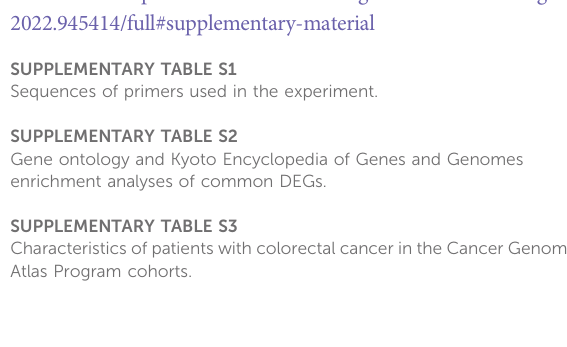
SUPPLEMENTARY TABLE S1 Sequences of primers used in the experiment. SUPPLEMENTARY TABLE S2 Gene ontology and Kyoto Encyclopedia of Genes and Genomes enrichment analyses of common DEGs. SUPPLEMENTARY TABLE S3 Characteristics of patients with colorectal cancer in the Cancer Genome Atlas Program